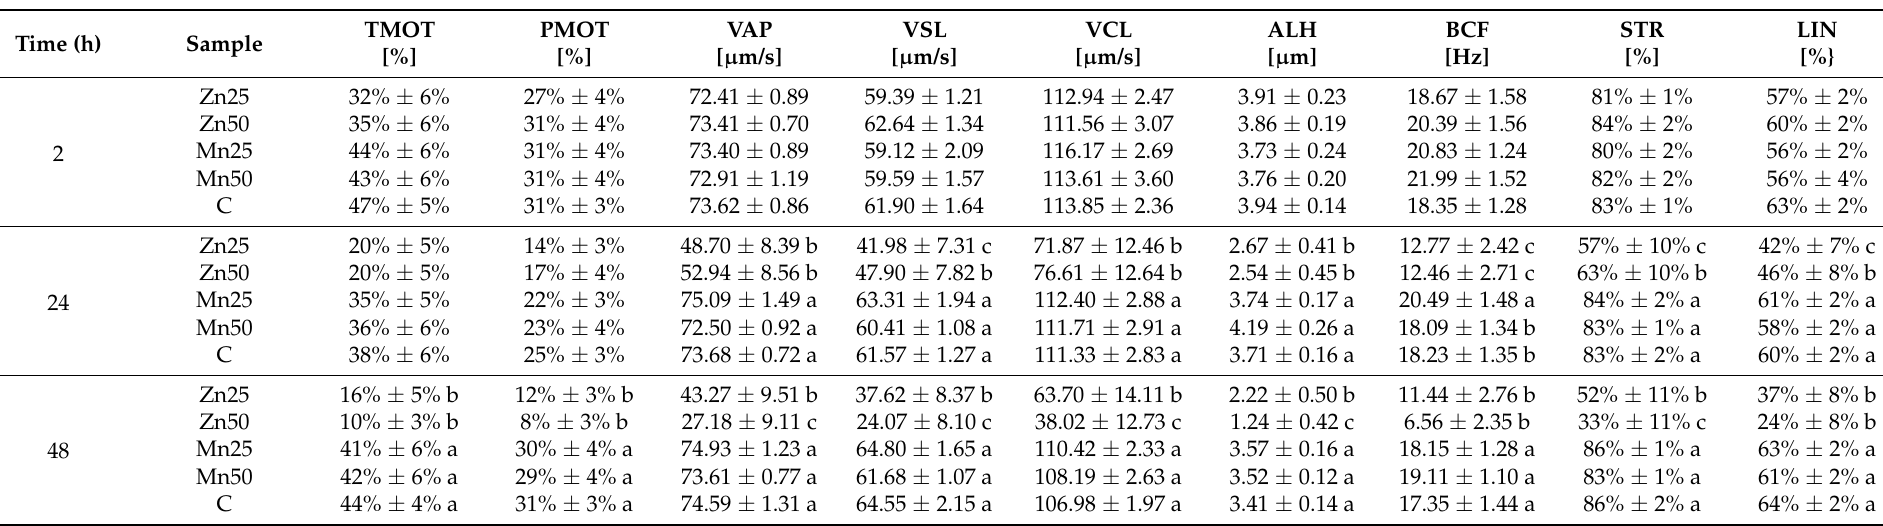
Table 1. The effect of time (hours) on the motility characteristics of turkey semen (mean ± SEM) preserved in a liquid state at 4 ◦ C with or without (C) the addition of ZnNPs and MnNPs. Time